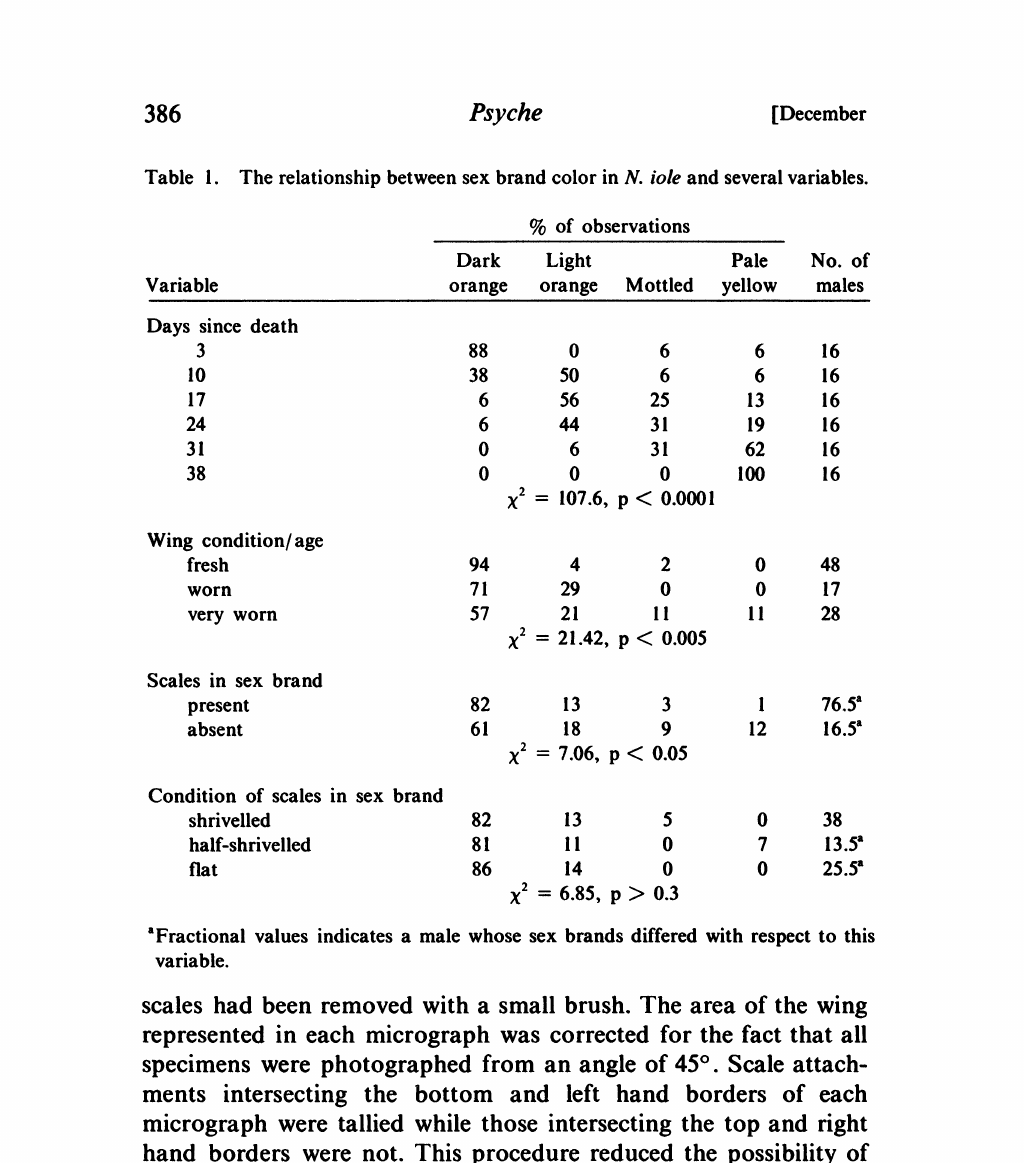
Table 1. The relationship between sex brand color in N. iole and several variables. % of observations Dark Light Pale No. of Variable orange orange